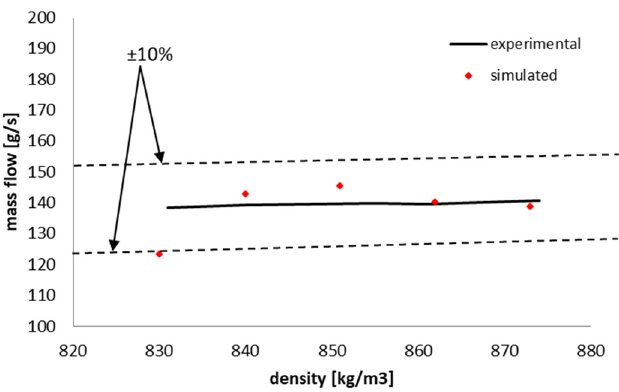
Figure 16. Experimental and numerical mass flow simulated for the densities and maximum solid particles stated in Table 5.